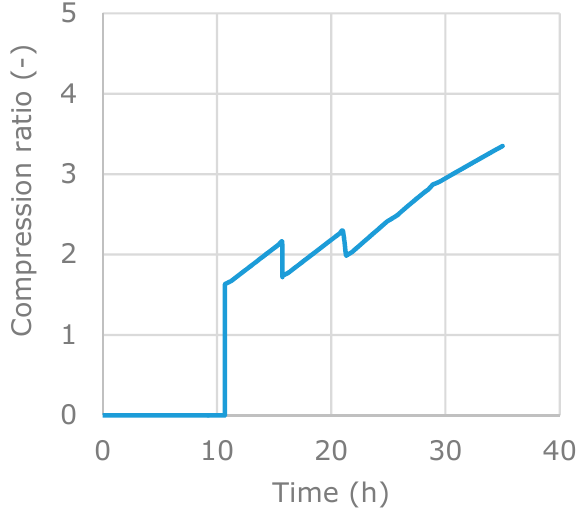
Figure 10. Compression ratio (adiabatic